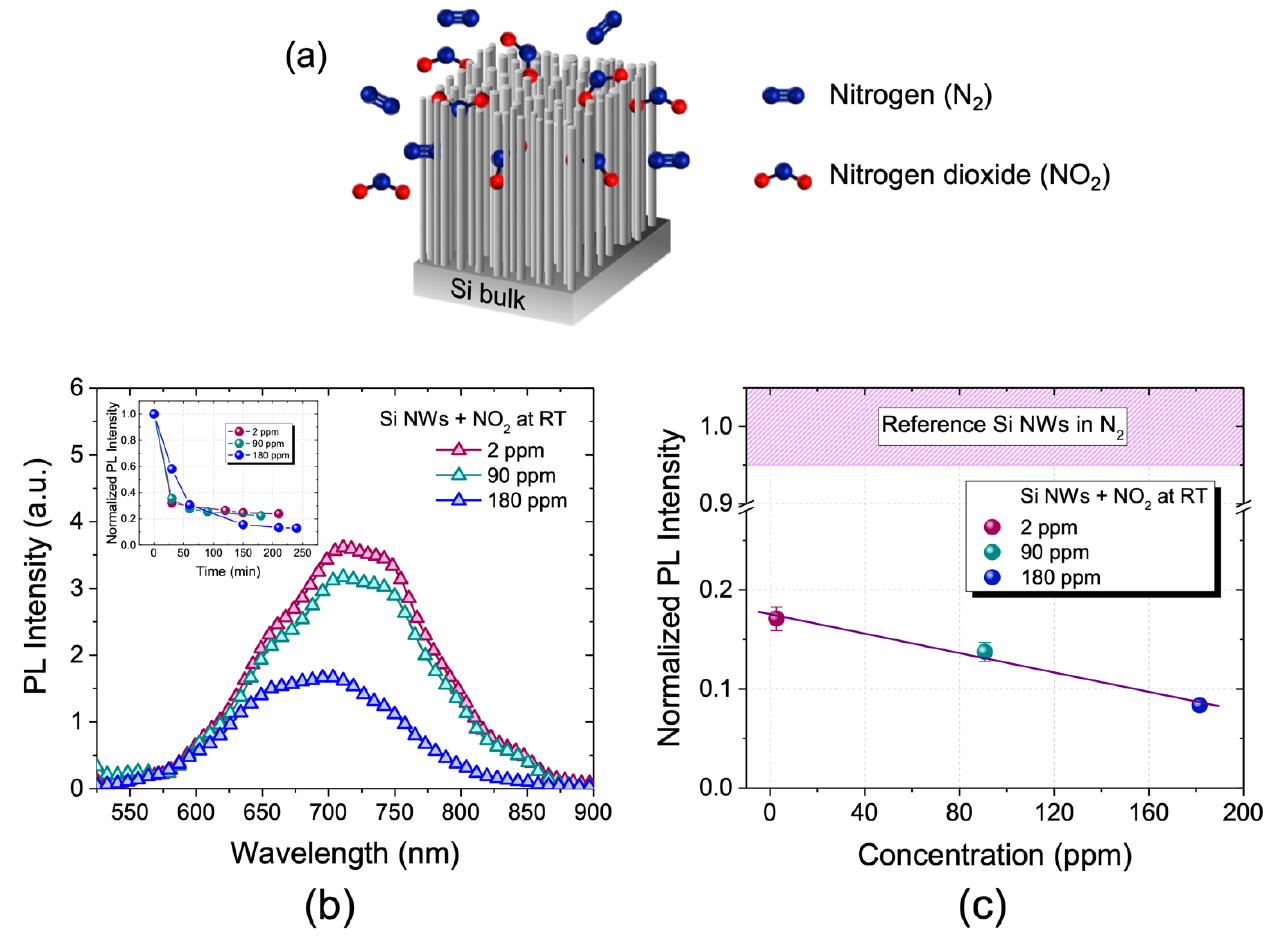
Figure 2. ( a ) Schematic representation of the Si NW sensor in the presence of the N 2 /NO 2 gas mixture. ( b ) RT photolumi- nescence spectra of the sensor exposed to 2 ppm NO 2 (red line), 90 ppm NO 2 (green line), and 180 ppm NO 2 (blue line). ( c ) Calibration curve of the sensor at room temperature.